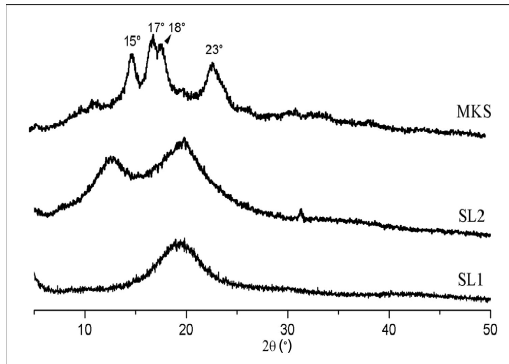
Figure 3. XRD patterns of MKS and its starch esters.